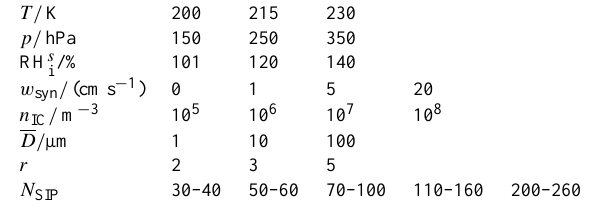
Fig. 5. PDFs of ice water contents (IWC) in a contrail-cirrus after Fig. 35. PDFs of ice water contents (IWC) in a contrail-cirrus after 4h. For the dotted line, the 2-D IWC field was smoothed with a sim- 4 hours. For the dotted line, the 2D IWC field was smoothed with ple box car average prior to the computation of the PDF. Parameter a simple box car average prior to the computation of the PDF. Pa- settings of the simulations are listed in Tables 1 and rameter settings of the simulations are listed in Tables 31 and 32.